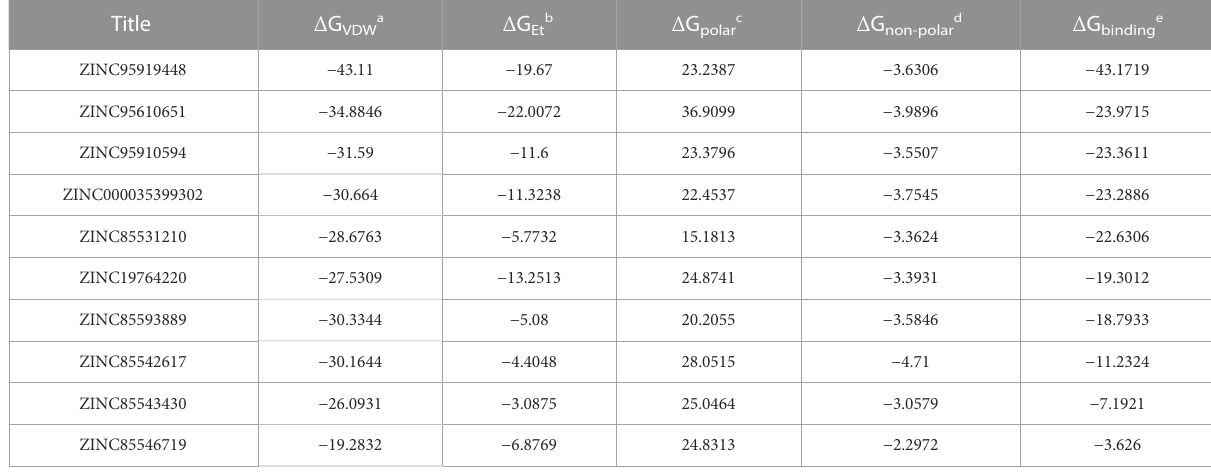
TABLE 2 Binding free energy details of top10 compounds.